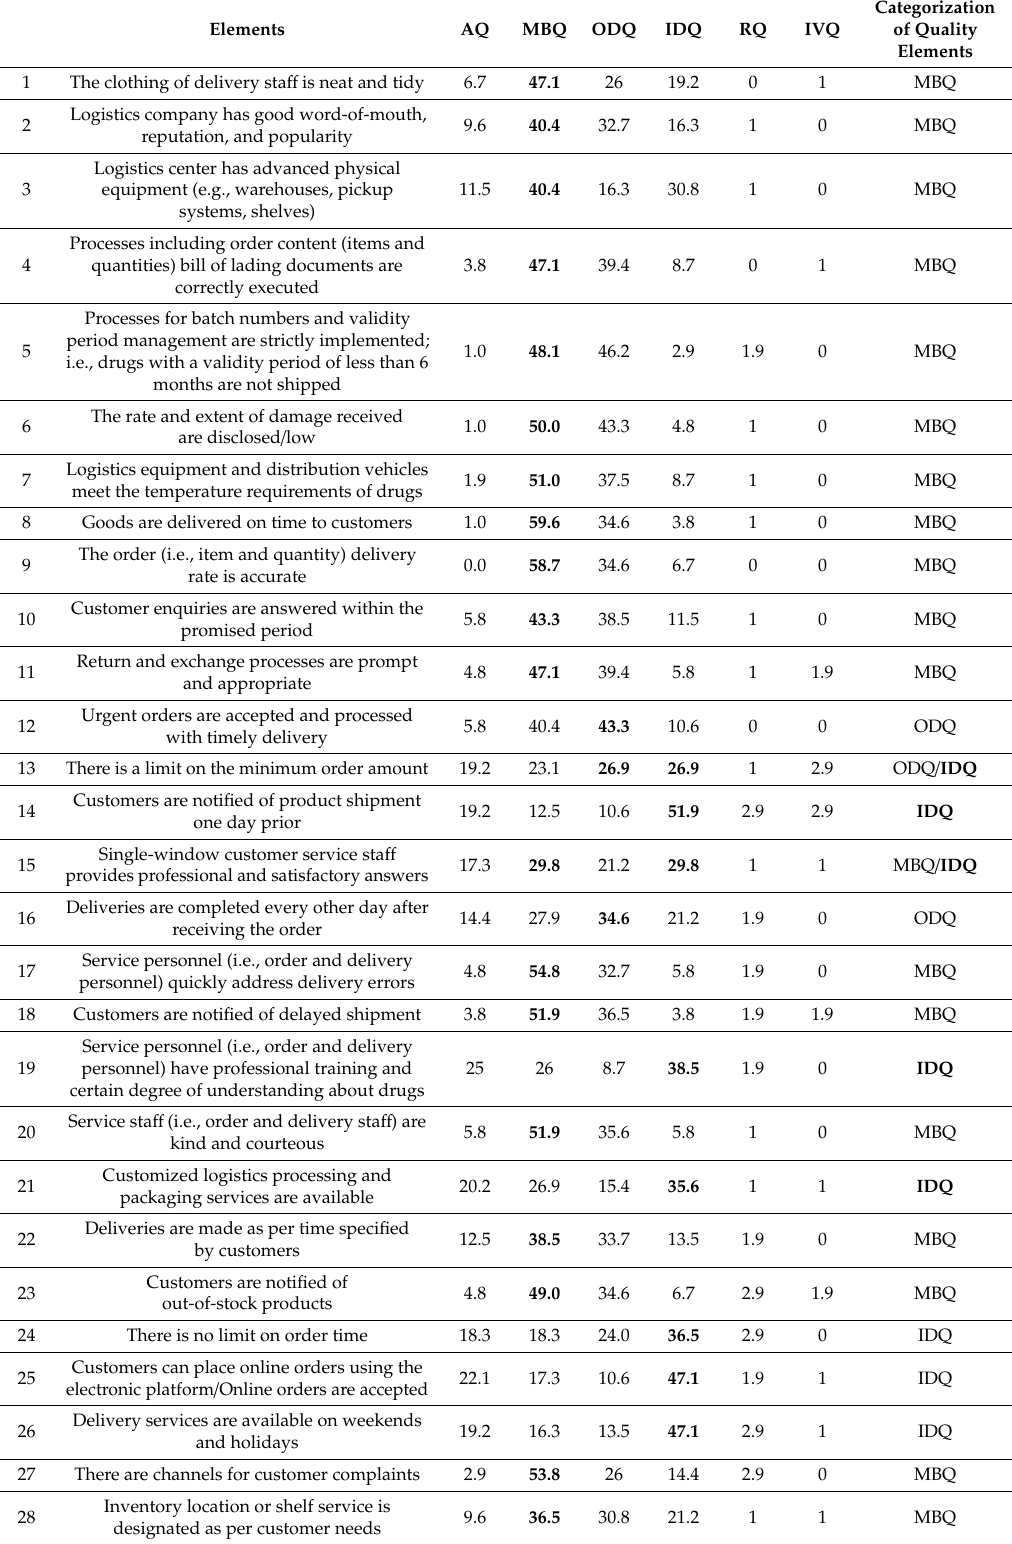
Table 3. Categorization of quality elements listed by respondents